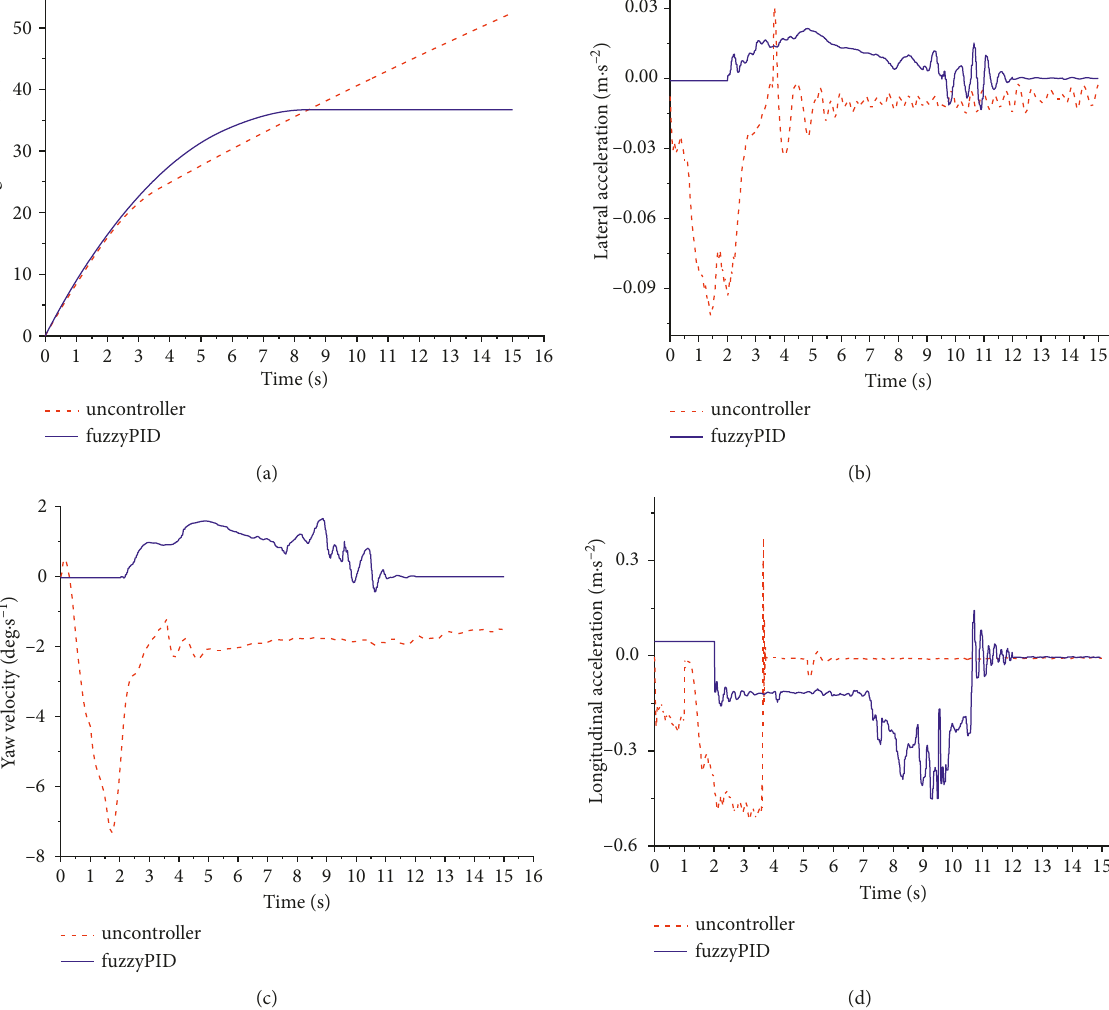
Figure 33: HIL test diagram under curve operating conditions when u � 0.8. (a) Braking distance. (b) Lateral acceleration. (c) Yaw velocity. (d) Longitudinal